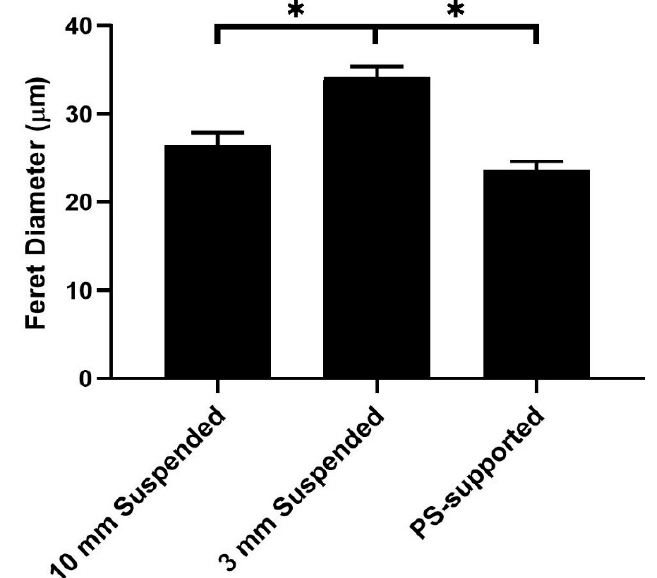
Figure 5. Glioblastoma cell Feret diameter on supported (PS) and suspended (10 mm, 3 mm) 50 µm EFMs. Scaffolds are arranged left to right by increasing indentation modulus. A total of 935 cells were analyzed across at least two independent experiments. Levels connected by a star (*) are statistically significant from each other ( p < 0.05).